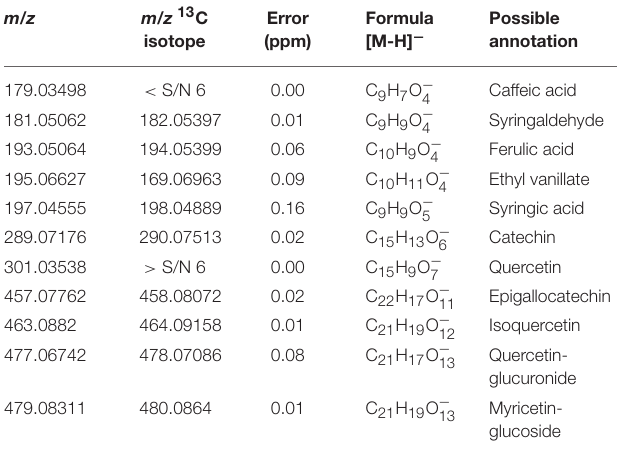
TABLE 2 | Subset of exact masses of the first and second ( 13 C) isotope present in SB and/or BB barrelwood and whisky samples FT-ICR-MS spectra, which could be assigned to elemental formulae containing C, H, and O with associated absolute errors of assignment in ppm and possible compound annotation based on our database.